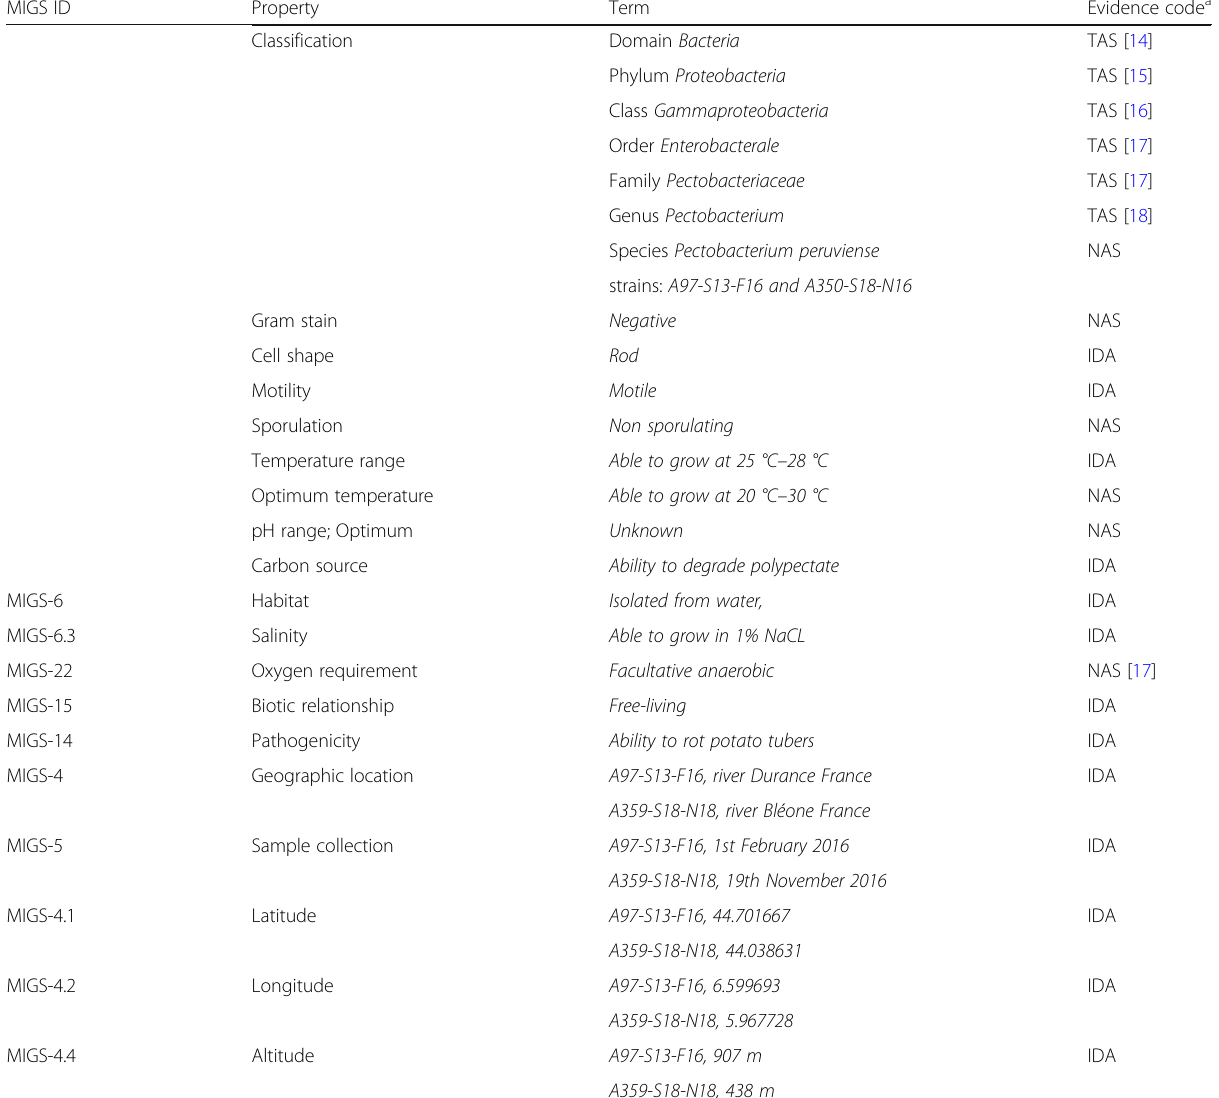
Table 1 Classification and general features of strains A97-S13-F16 and